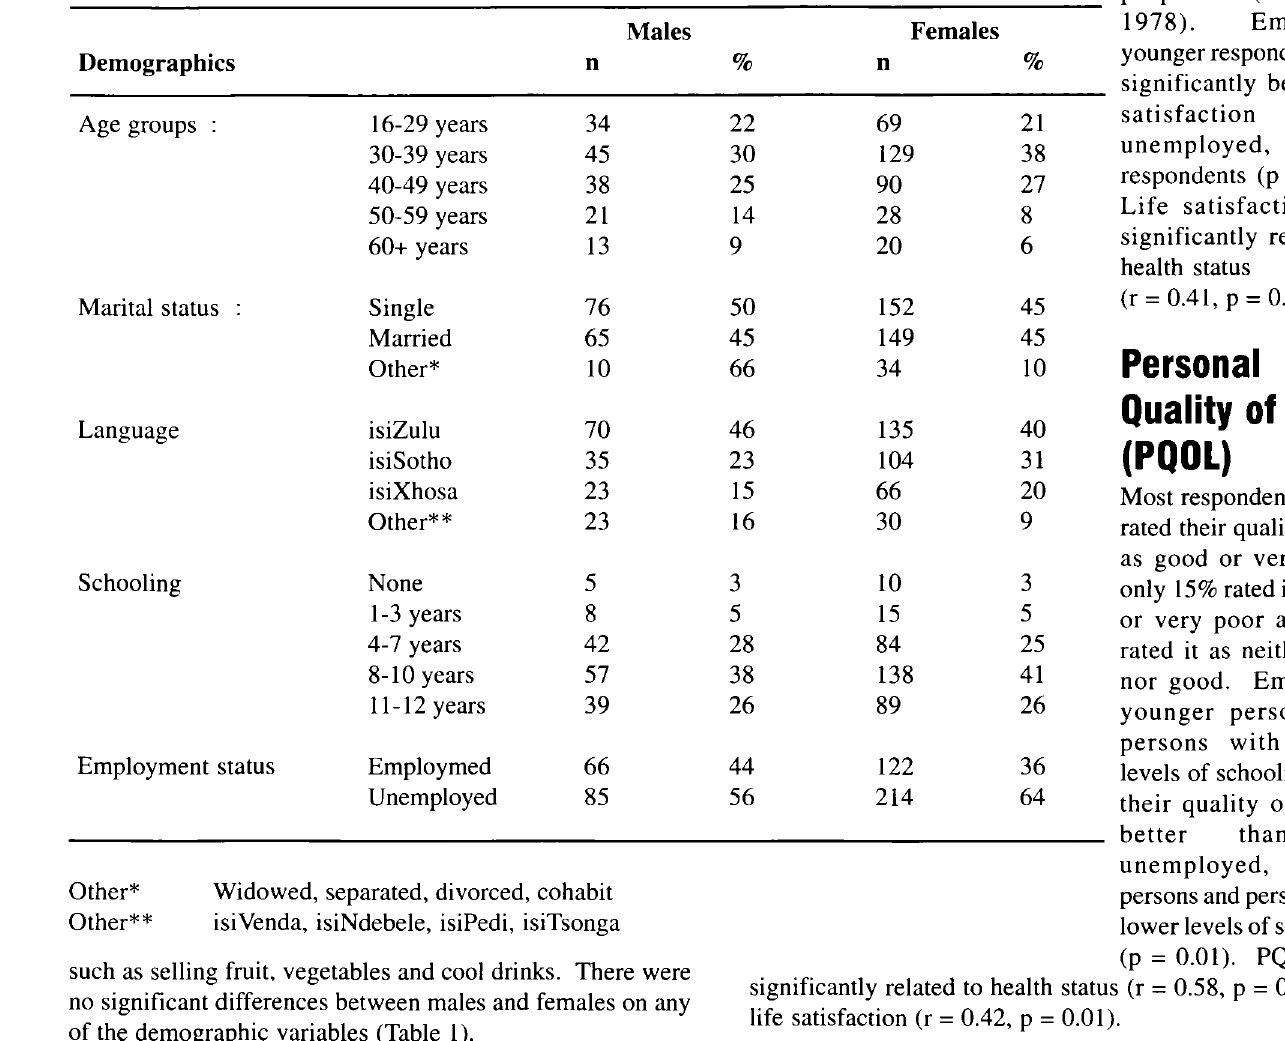
Table 1 : Demographic Information by Gender